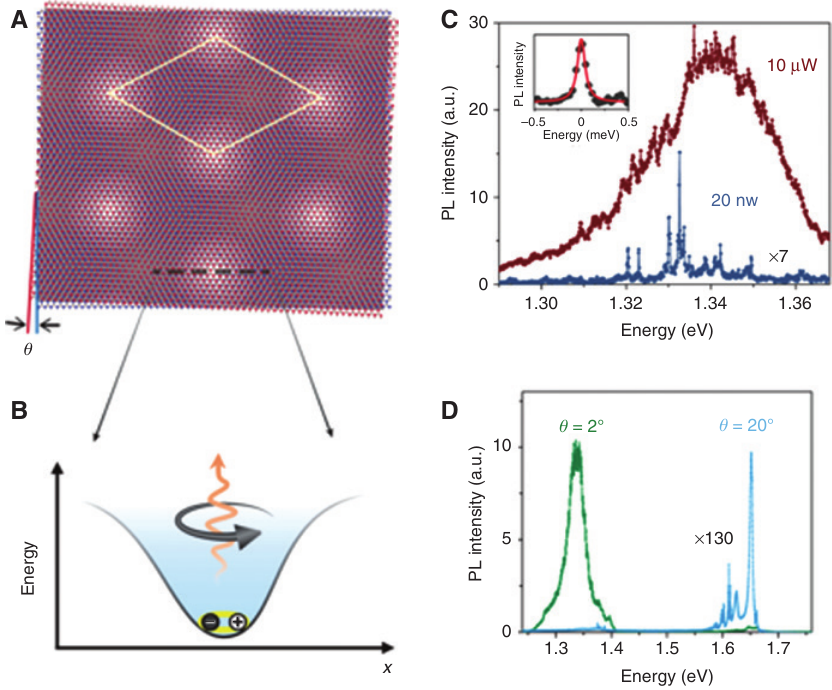
Figure 5: Exciton trapping by Moiré superlattice. (A) Illustration of the moiré superlattice formed in a heterobilayer with twist angle θ . (B) Schematic of an exciton trapped in a moiré potential site. (C) Comparison of interlayer exciton PL from a heterobilayer with a 2 ° twist angle at excitation powers of 10 μ W (dark red) and 20 nW (blue; intensity scaled by 7 × ). Inset, a Lorentzian fit to a representative PL peak indicates a linewidth of approximately 100 μ eV (20 nW excitation power). (D) PL spectra from heterobilayers with twist angles of 2 ° (green) and 20 ° (blue; intensity scaled by 130 × ) at an excitation power of 5 μ W. a.u., arbitrary units. Reproduced with permission from Ref. [73], Nature Publishing